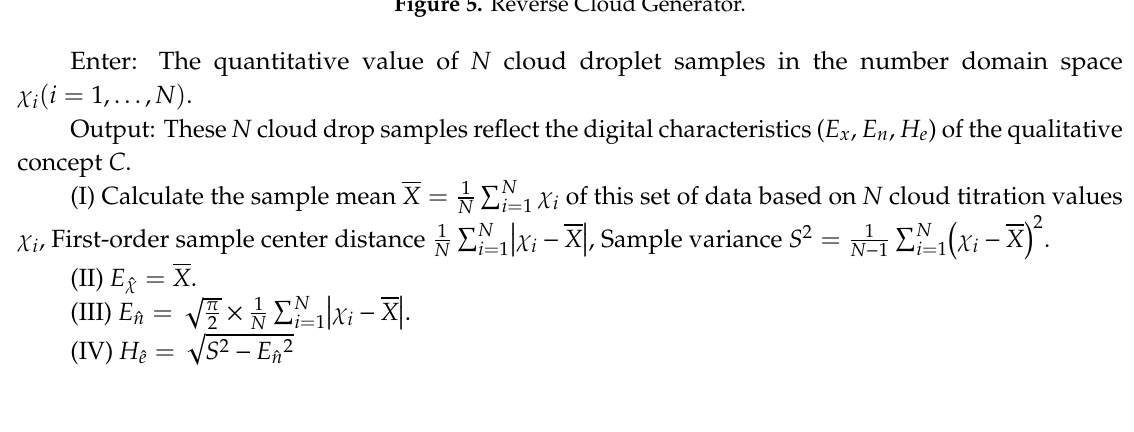
Figure 5. Reverse Cloud Generator.